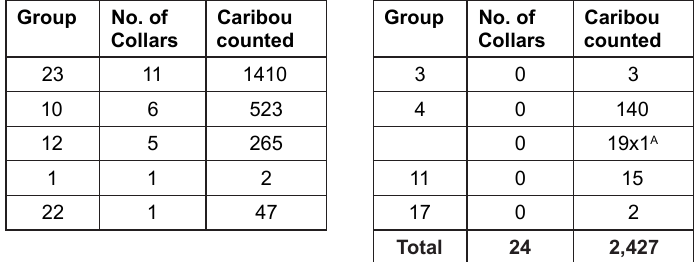
Table 31. Field data collected for Cape Bathurst 2012 post calving survey.